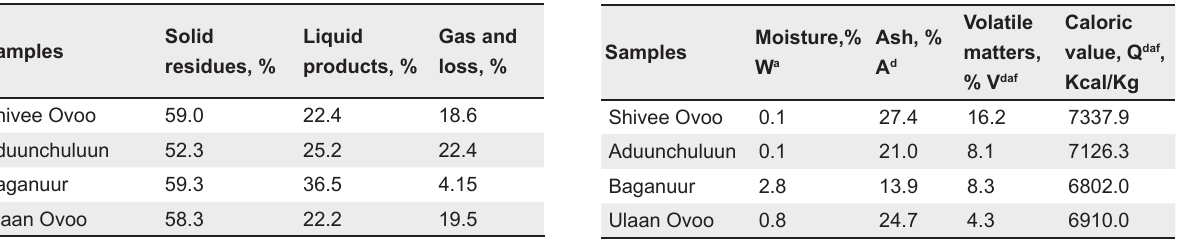
Table 3. Main technical characteristics of the